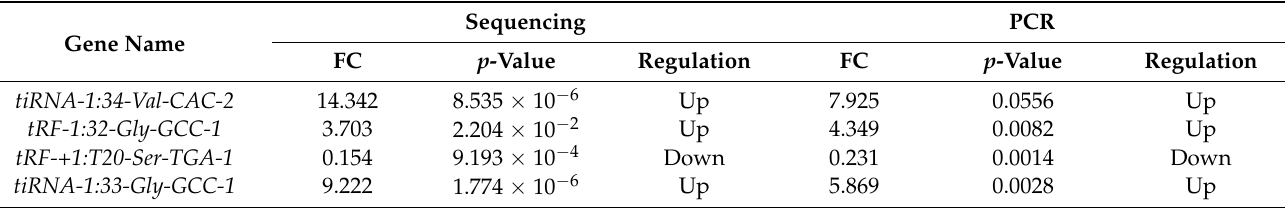
Table 3. Comparison for candidate tsRNAs expression in sequencing and PCR (T vs. N; FC, fold